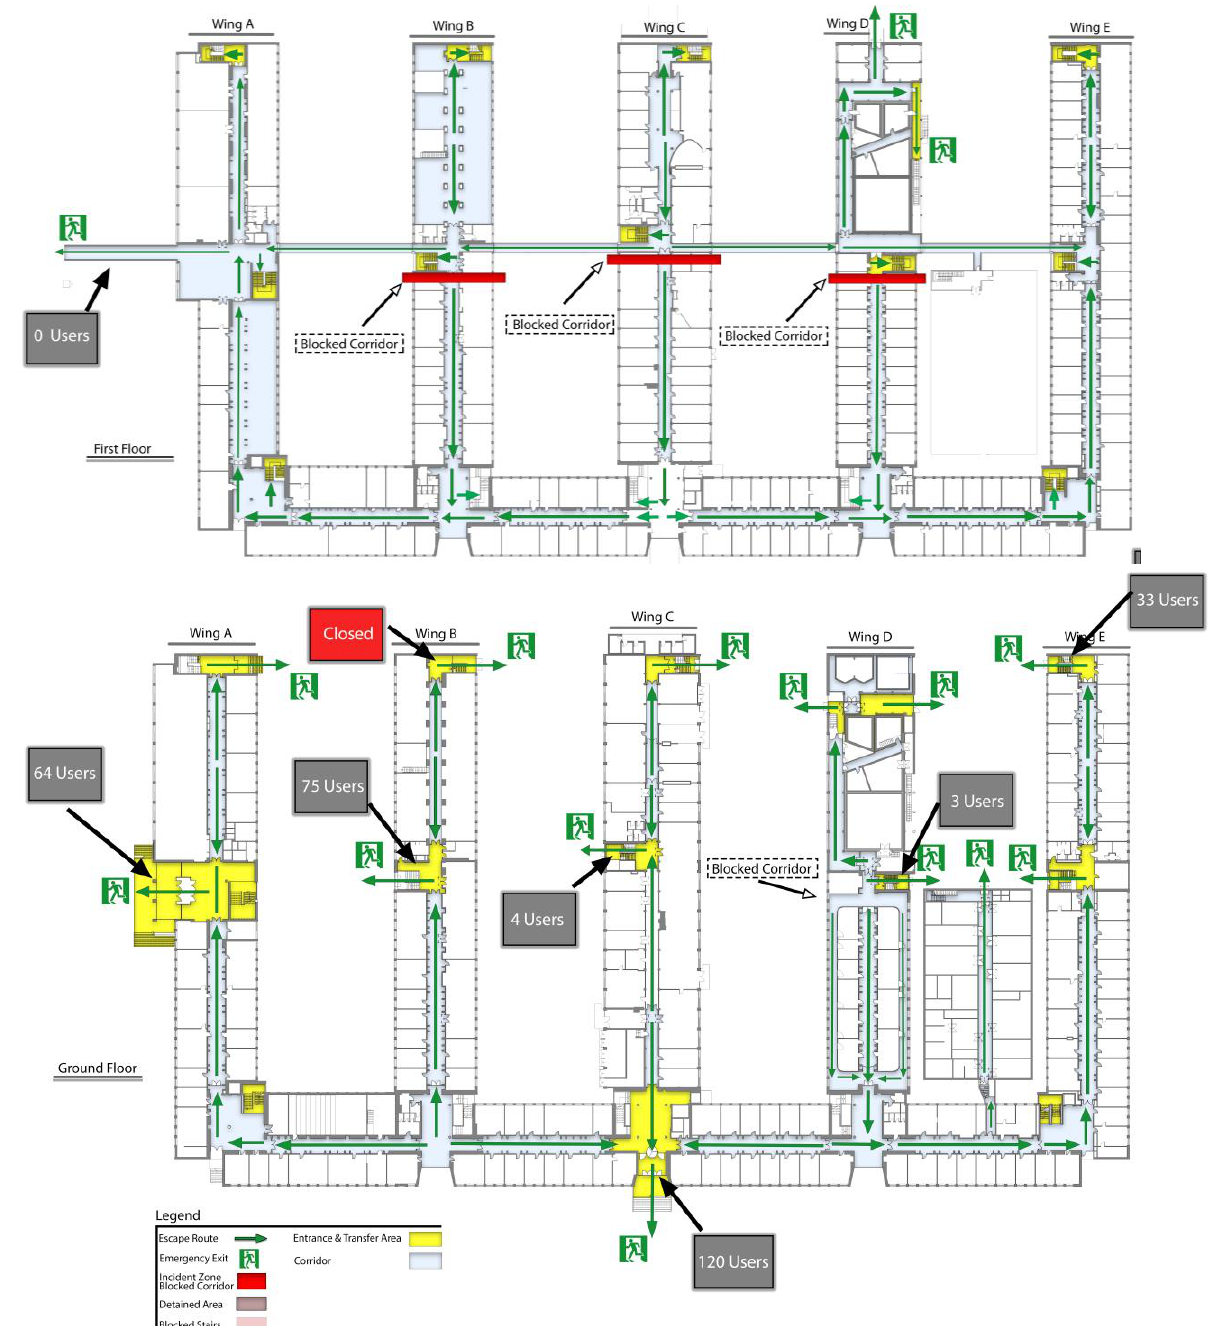
Figure 8. 2D floor plans represents the number of users that escape from the